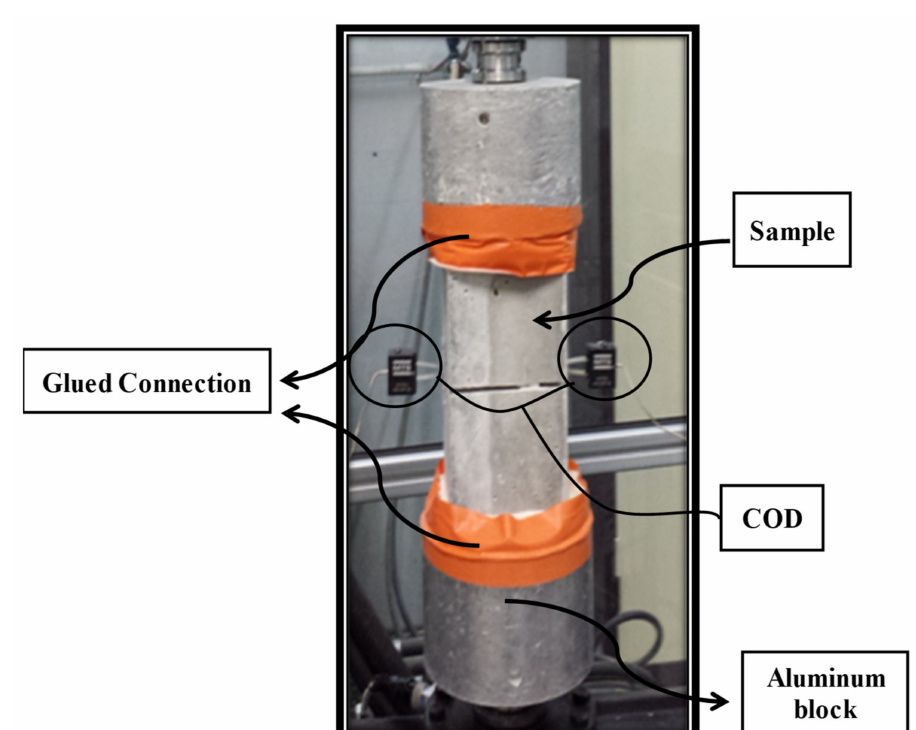
Figure 5. Experimental setup for direct tensile